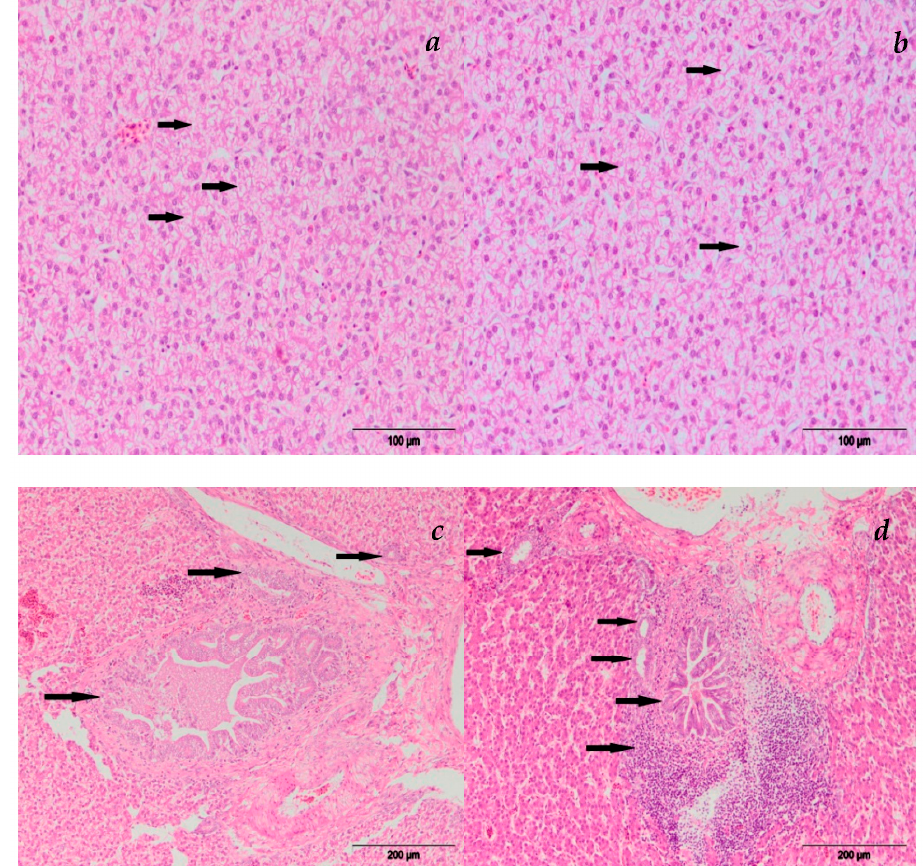
Figure 2. Liver HE staining of broiler chicks fed with diets containing AFB1 and T‑2 toxin combina‑ tion: ( a ) group E‑III hydropic degeneration; ( b ) group E‑IV hydropic degeneration; ( c ) group E‑III cholangitis; and ( d ) group E‑IV cholangitis and pericholangitis.